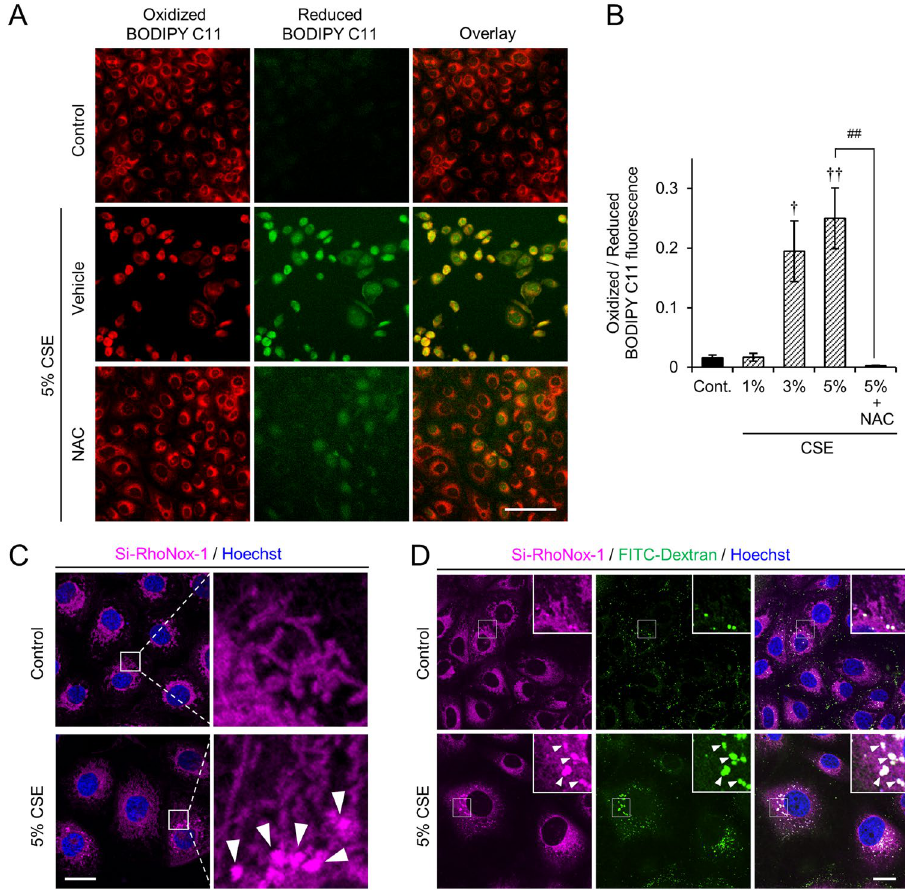
Figure 2. Exposure of HCE-T cells to CSE resulted in lipid peroxidation and autolysosomal iron accumulation. ( A ) Representative images of BODIPY 581/591 C11 (BODIPY C11) fluorescence in live HCE-T cells incubated without (control) or with 5% CSE in the presence of vehicle (PBS) or 1 mM NAC for 24 h. ( B ) The fluorescence intensity ratios for oxidized (green) and reduced (red) BODIPY C11. The data are represented as the mean ± SEM (n = 6). † P < 0.05, †† P < 0.005, Dunnett’s test vs. Control (Cont); ## P < 0.005, Student’s t -test vs. 5% CSE. ( C ) Representative images of iron distribution in live HCE-T cells following CSE exposure. The cells were incubated with Si-RhoNox-1 (magenta) and Hoechst 33342 (blue), 30 min before recording. The enlarged views of the boxed regions are shown on the right. ( D ) Intracellular distributions of Si-RhoNox-1 in FITC-dextran (green) and Hoechst 33342 (blue) stained HCE-T cells with or without CSE exposure. The enlarged views of the boxed regions are shown at the upper right corners. The arrowheads indicate iron accumulation at the perinuclear regions. Bar = 100 µm ( A ), 20 µm ( C , D